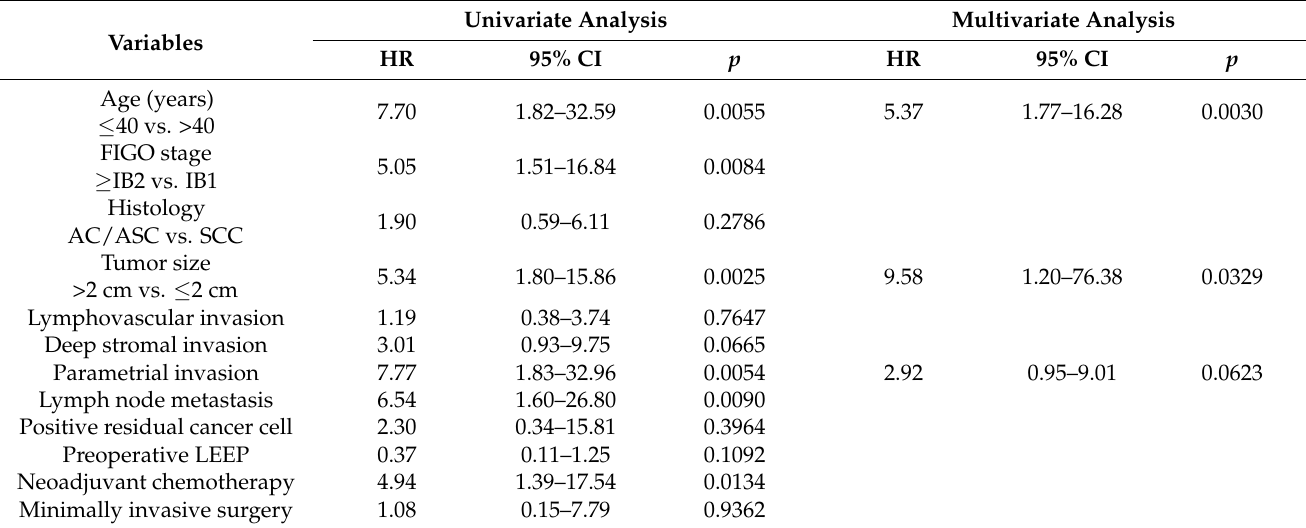
Table 3. Univariate and multivariate analyses of clinical variables for the prediction of death.